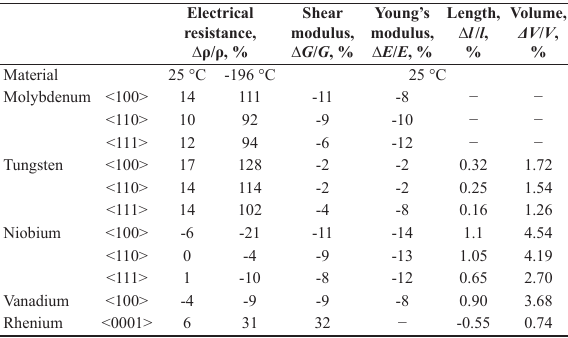
Table 1. Changes in the properties of the refractory metals as a re- sult of neutron irradiation (1.14×10 26 n/m 2 , Е > 0.1 MeV, 460 °С). Electrical